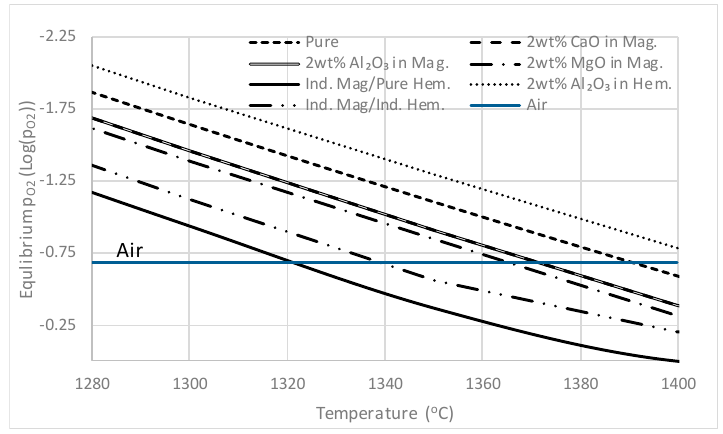
Figure 17. The calculated oxygen pressures for equilibrium between hematite to magnetite phases of selected compositions.